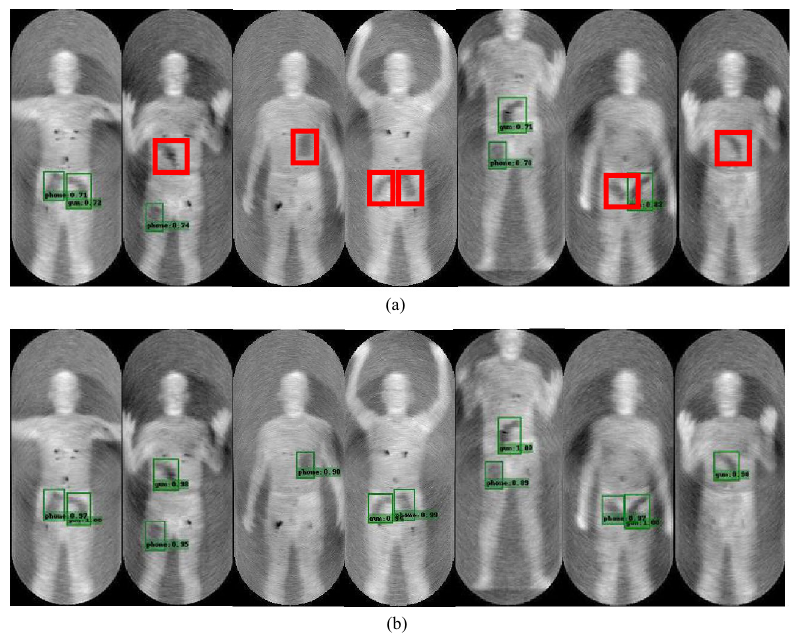
Figure 14. Visualized results of the passive terahertz dataset. ( a ) Detection results of the original SSD algorithm. ( b ) Detection results of the improved SSD algorithm.